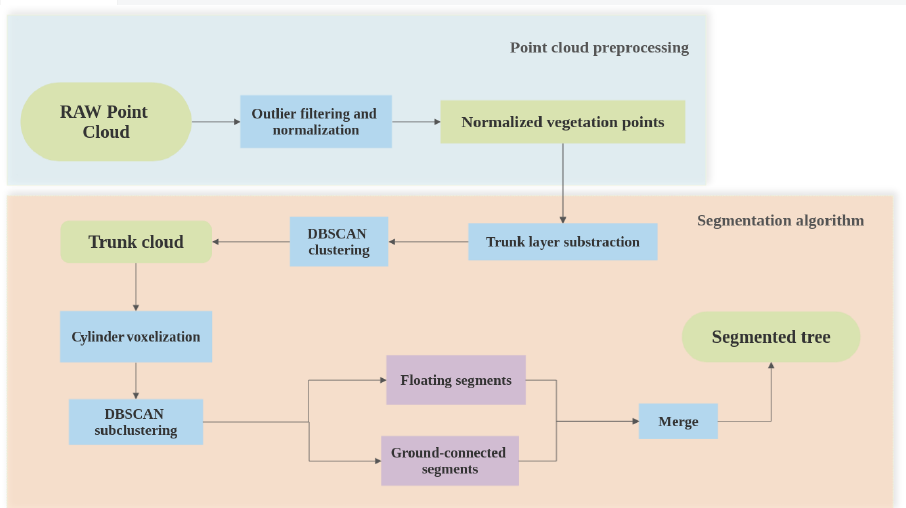
Figure 3. Workflow for the IT